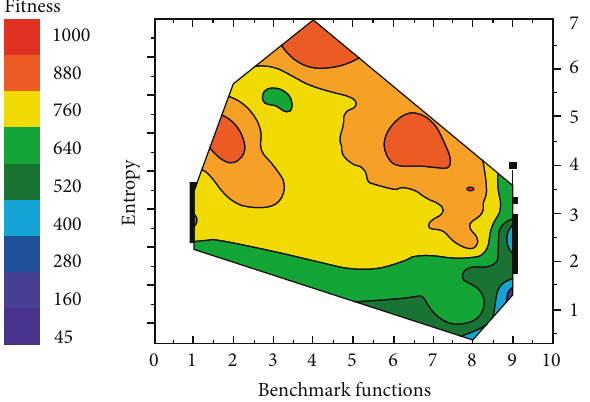
Figure 11: Entropy density